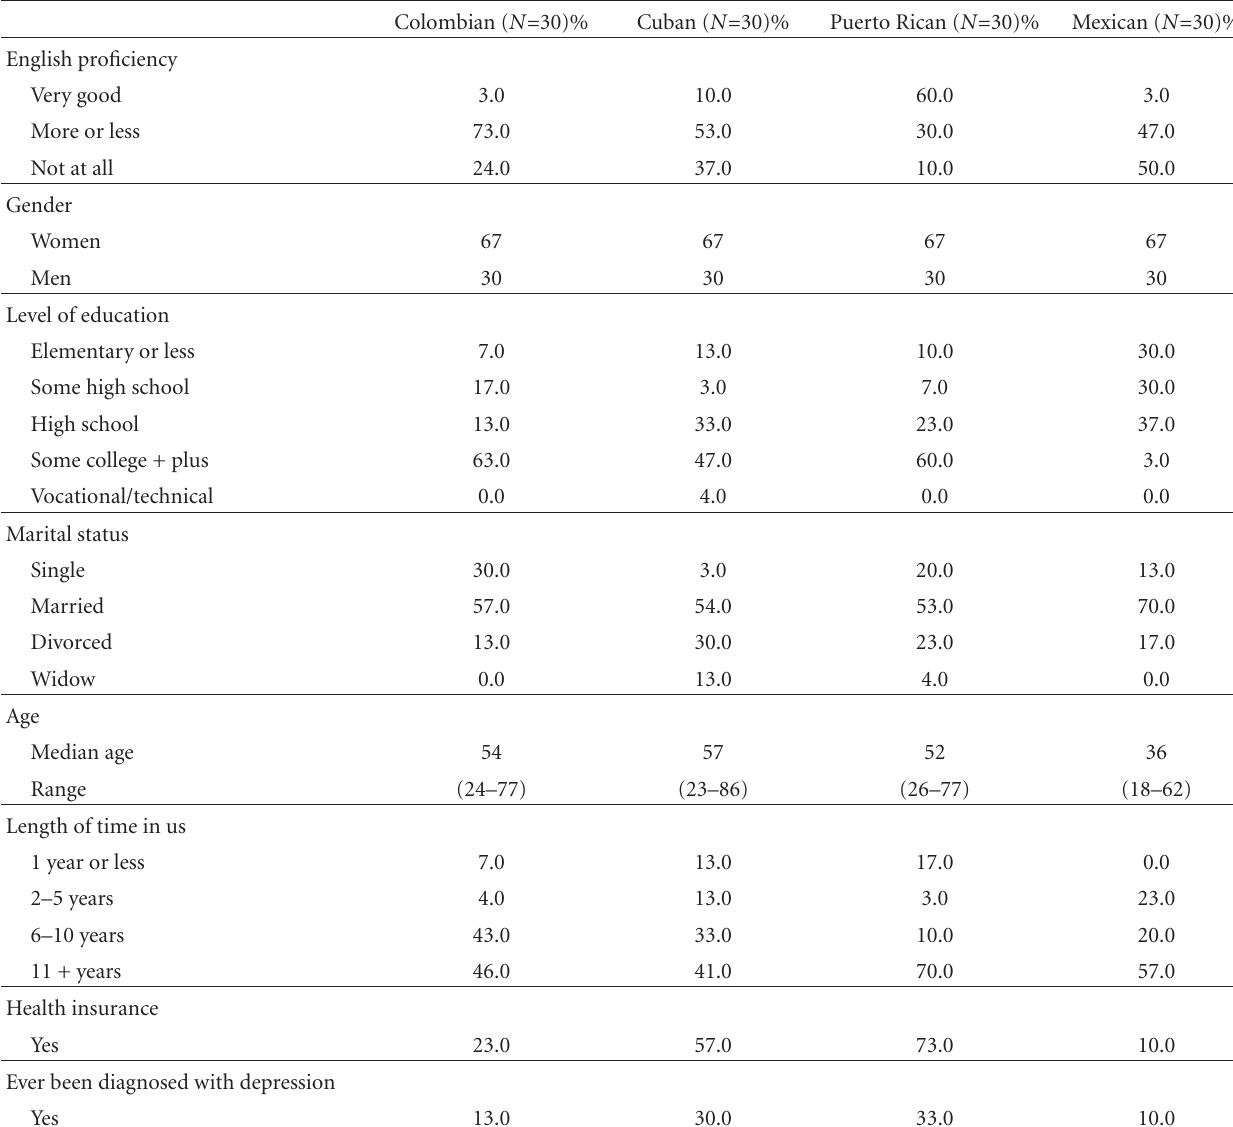
Table 1: Sample demographics: Latino